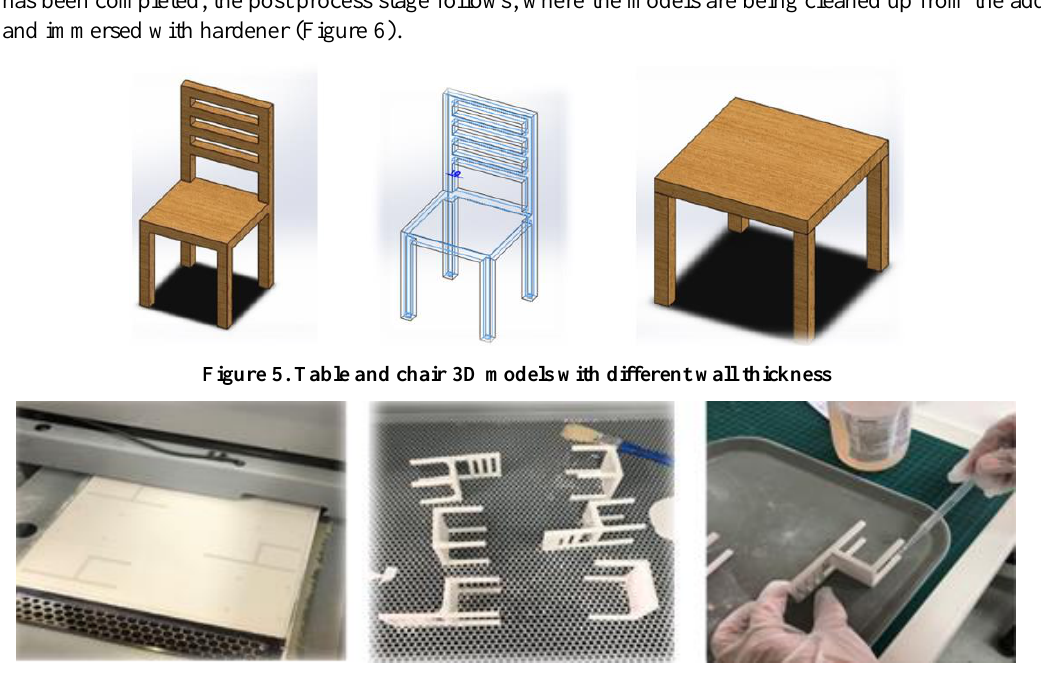
Figure 6. Printing and post processing Process